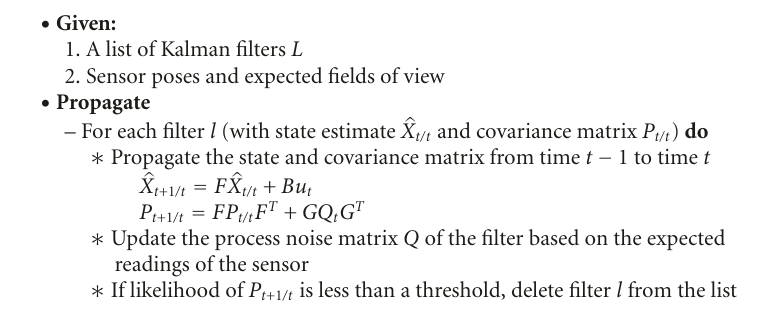
Algorithm 3: Multiple hypothesis state estimation propagation algorithm.